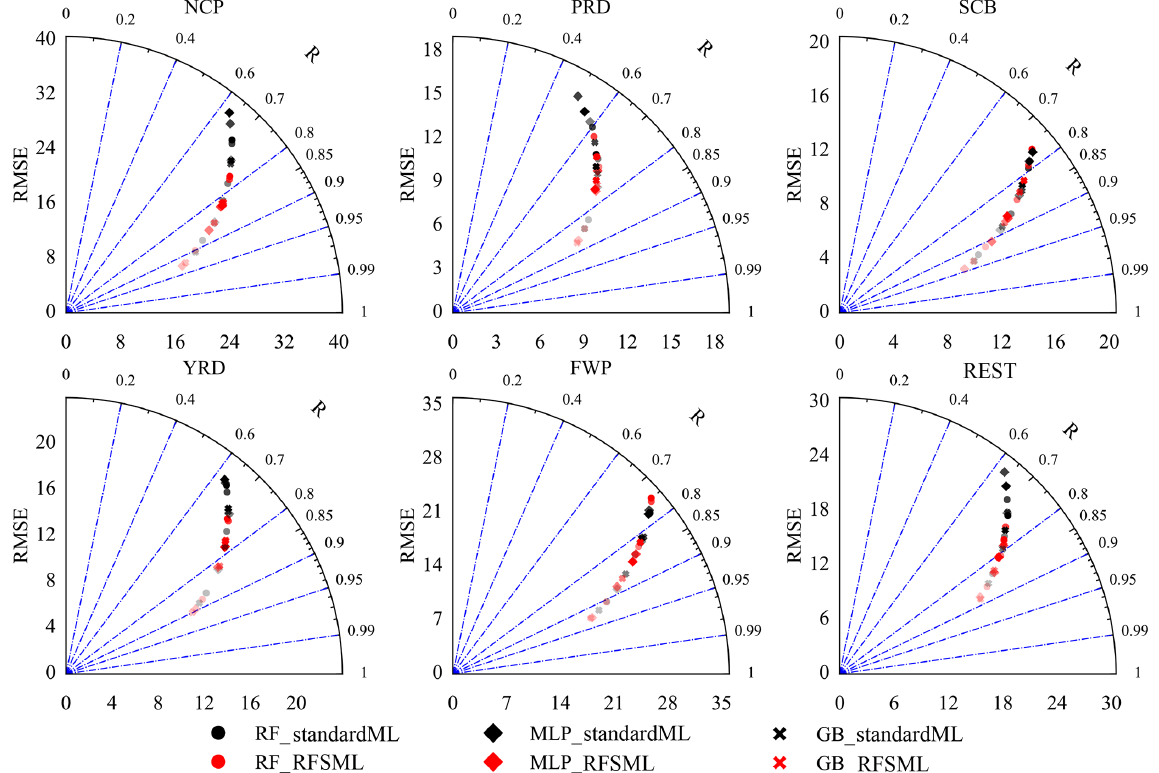
Figure 8. A modified Taylor diagram that illustrates RMSE and correlation coefficient values in six regions. The black and red colors represent forecasts with standard machine learning models and RFSML. Round, diamond, and fork shapes represent RF, MLP, and GB respectively. The transparency of markers indicates the four prediction horizons, where the transparency increases as the forecast hours